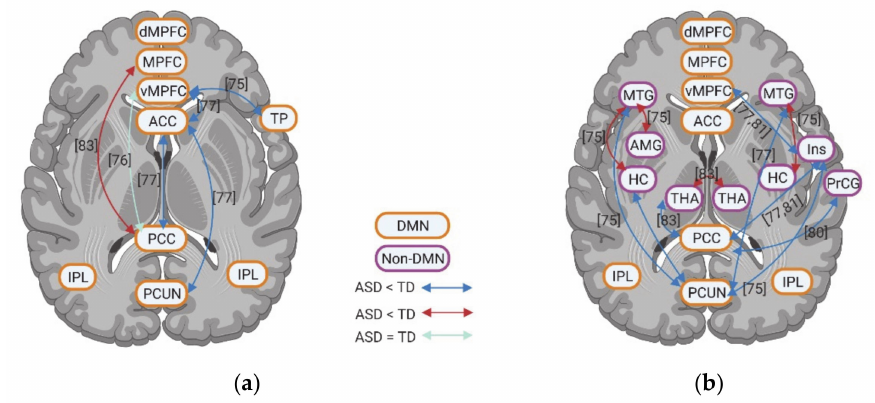
Figure 4. Dynamic functional connectivity between regions within DMN regions ( a ) as well as between DMN and non-DMN regions ( b ) for individuals with ASD compared to TD. The numbers in the figure correspond to the study numbers in Table